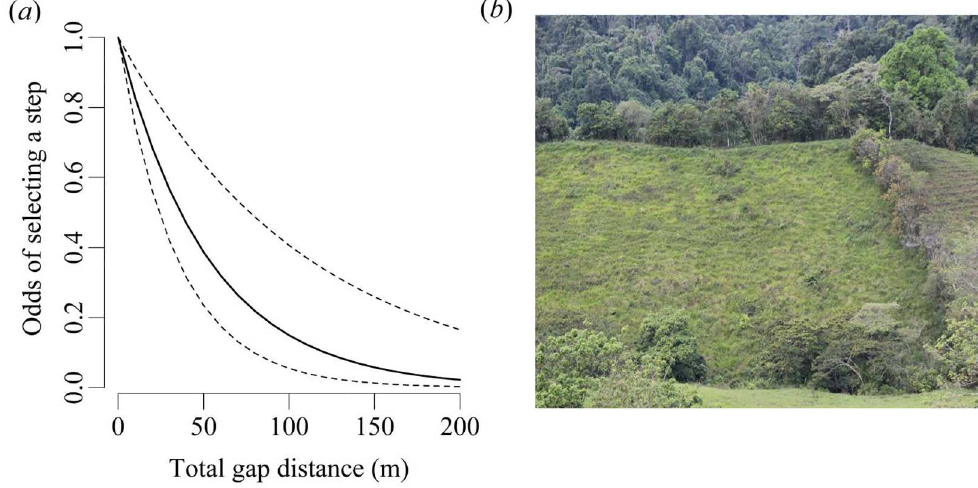
Fig 2. (a) Effect of total gap distanceon the odds of the green hermit hummingbird choosinga given step, as calculatedfrom the top step selectionfunction model provided in Table 2. (b) Large gaps in tropical forest are unlikelyto be crossed.